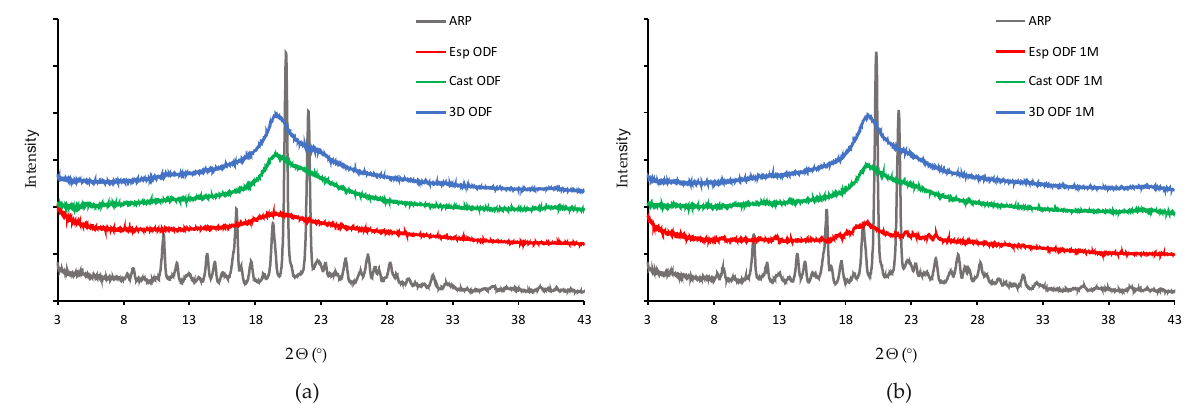
Figure 5. XRD diffraction patterns ( a ) directly after ODFs preparation; ( b ) after one month of storage at 25 °C and 60% RH) of raw ARP (gray line) and ODFs prepared by electrospinning (red line), casting (green line), and 3D printing (blue line) method.